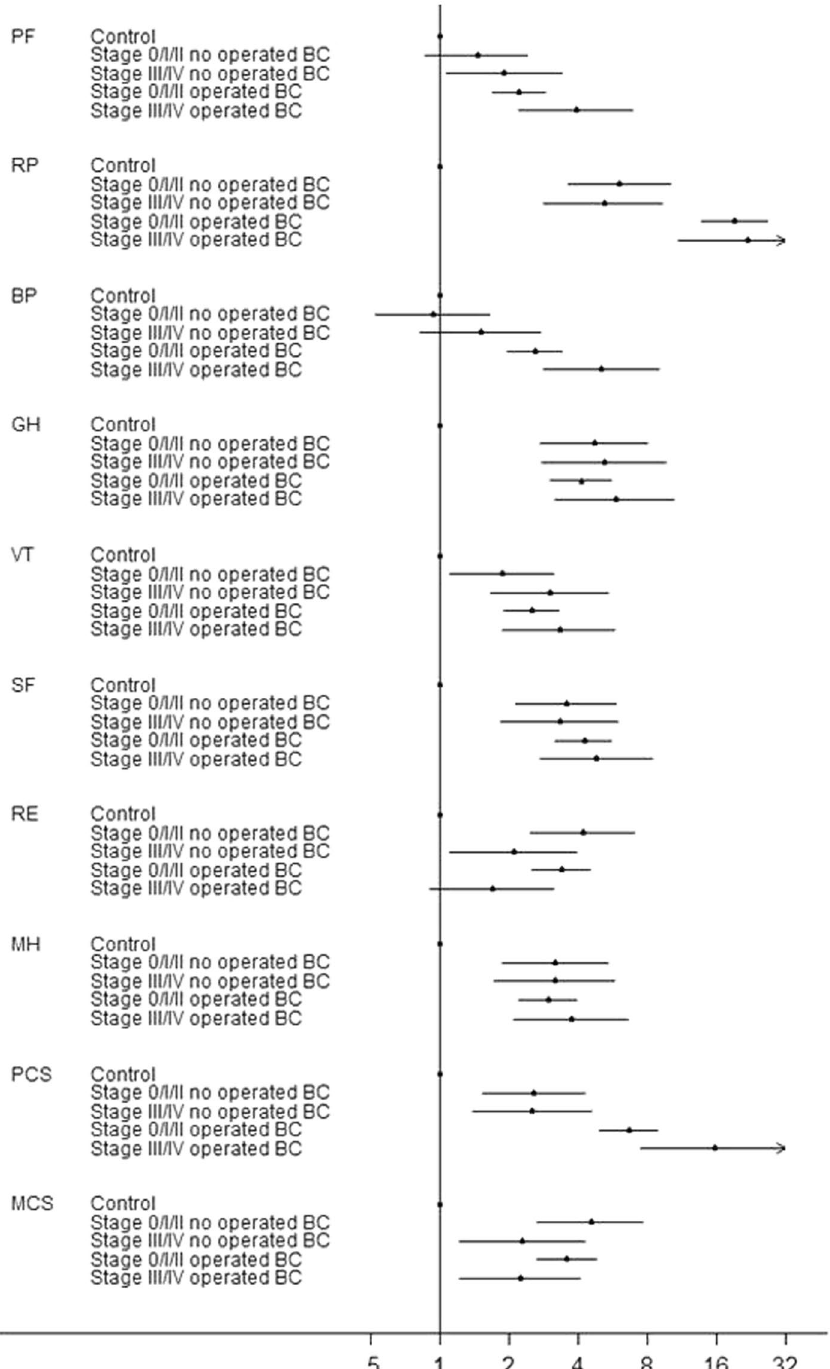
Figure 3. ORs of low scores a in the eight SF-36 scales and the two summary components for breast cancer cases compared to control women in the EpiGEICAM study, by tumour stage and surgical status. ORs adjusted by age, country of birth, region of residence, marital status, perceived social support, education, working status, caregiving, comorbidities, smoking, adherence to the WCRF/AICR recommendations, nulliparity, and family history of breast cancer. Values over 1 indicate higher odds of a low score. a Low scores defined as five or more points under the reference population mean, i.e. ≤ 45 points. BC: Breast cancer; PF: Physical Functioning; RP: Role-Physical; BP: Bodily Pain; GH: General Health; VT: Vitality; SF: Social Functioning; RE: Role-Emotional; MH: Mental Health; PCS: Physical Component Summary Score; MCS: Mental Component Summary